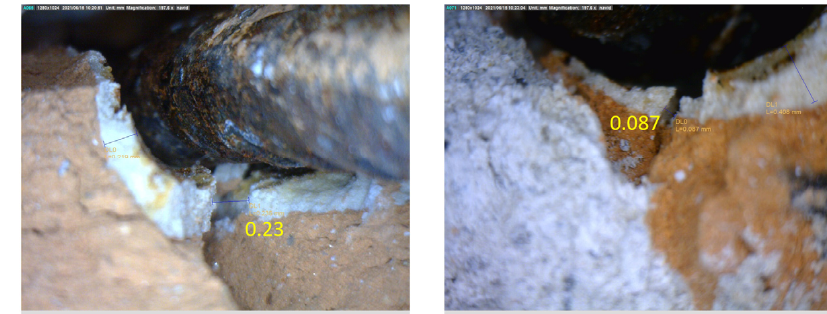
Figure 7. Examples for crack width.